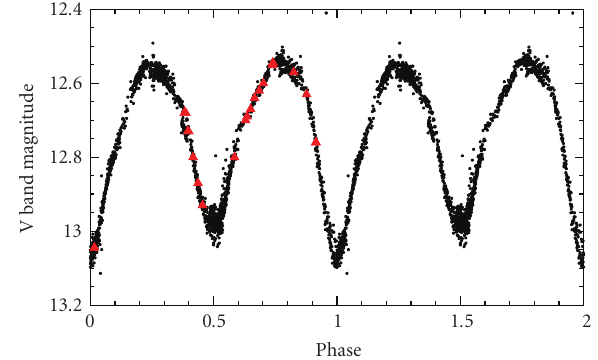
Figure 2: Folded lightcurve of B17 obtained by amateur astronomers. The red triangles show the phases where spectra were obtained